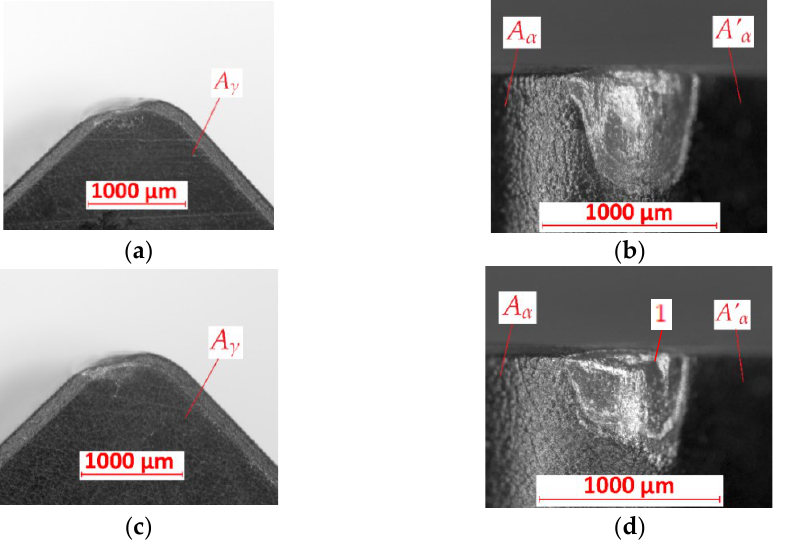
Figure 9. Results of tool’s wear measurements of cutting inserts after turning with f = 0.15 mm/rev of ( a , b ) FEPA 046 samples; ( c , d ) FEPA 100 samples: A γ —rake surface, A α —principal flank surface, A’ α —auxiliary flank